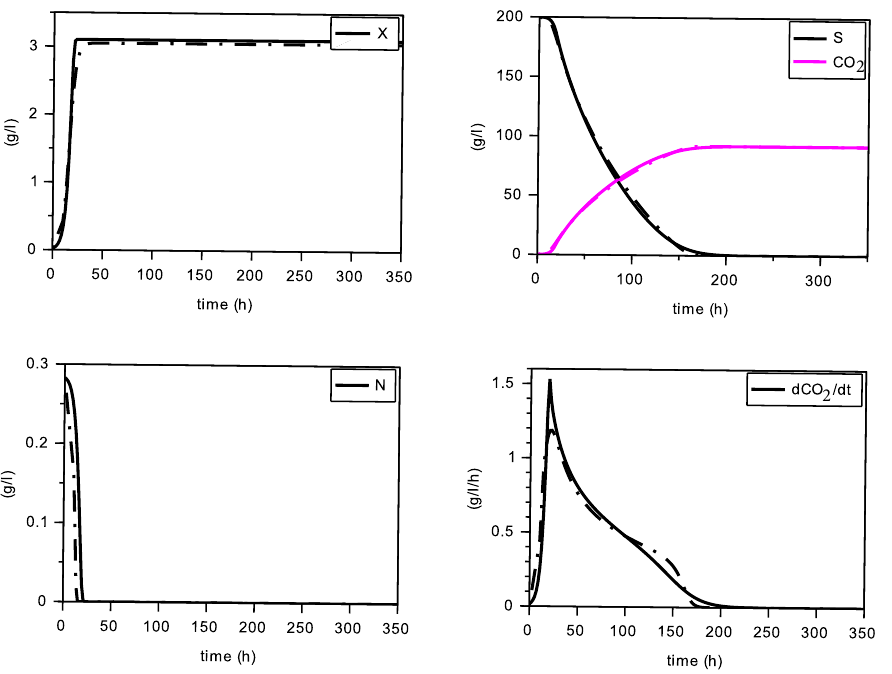
Figure 9. Comparison with the SOFA model (in dashed) for N ( 0 ) = 0.283 g · L − 1 (constant tempera- ture of 24 ◦ C).